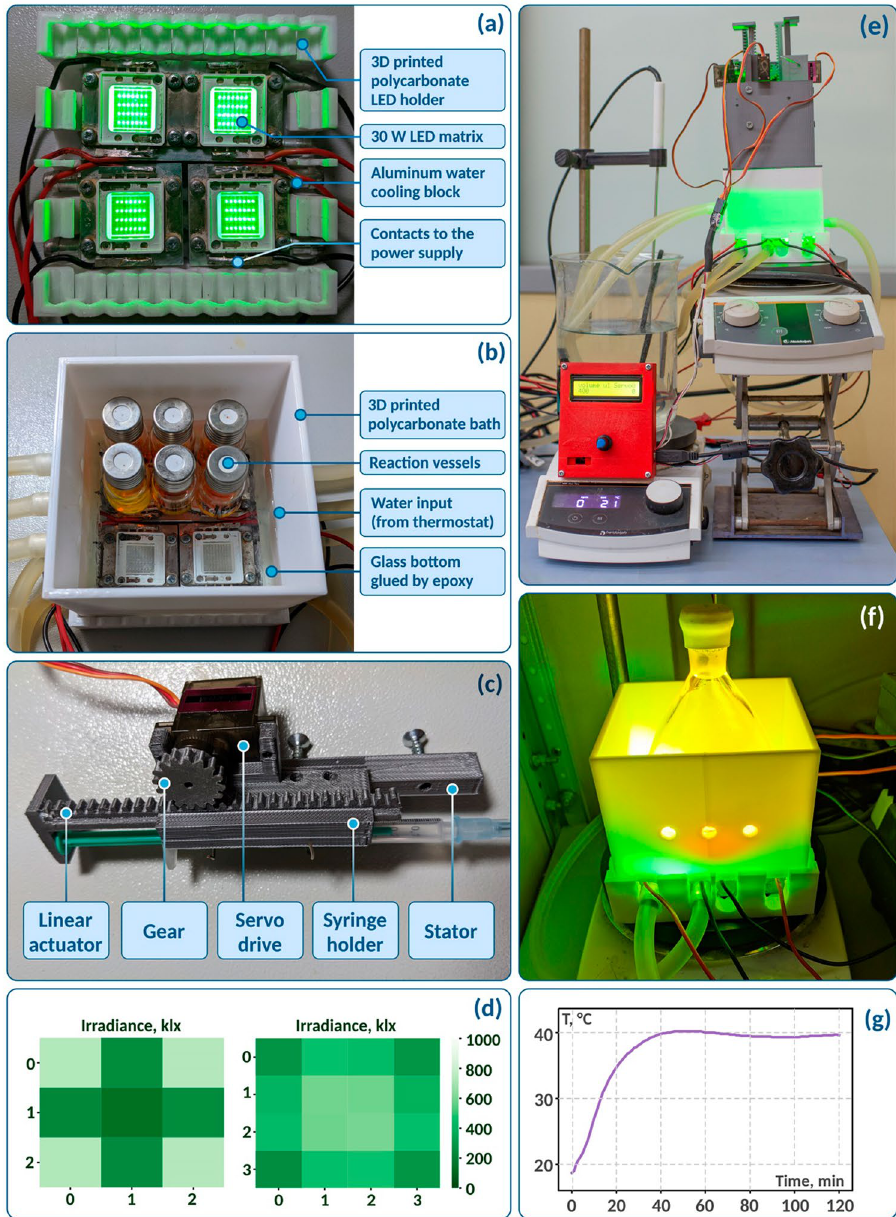
Figure 2. Custom build 3D printed photoreactor: ( a ) first layer is a matrix of four 30 W LEDs, cooled by water; ( b ) second layer is a full jacket with glass bottom; ( c ) third layer consists of four independent syringe pumps, made of 3D printed gears and controlling by servo motors and Arduino; ( d ) heatmaps of irradiance for possible vial positioning under LEDs measured with photodiode circuit; ( e ) completely assembled photoreactor; ( f ) gram-scale setup; ( g ) monitoring of temperature stability over a time period of 2 h at 40 °C. See Supplementary Figs. S3–S6 for dimensions of main parts of FFF